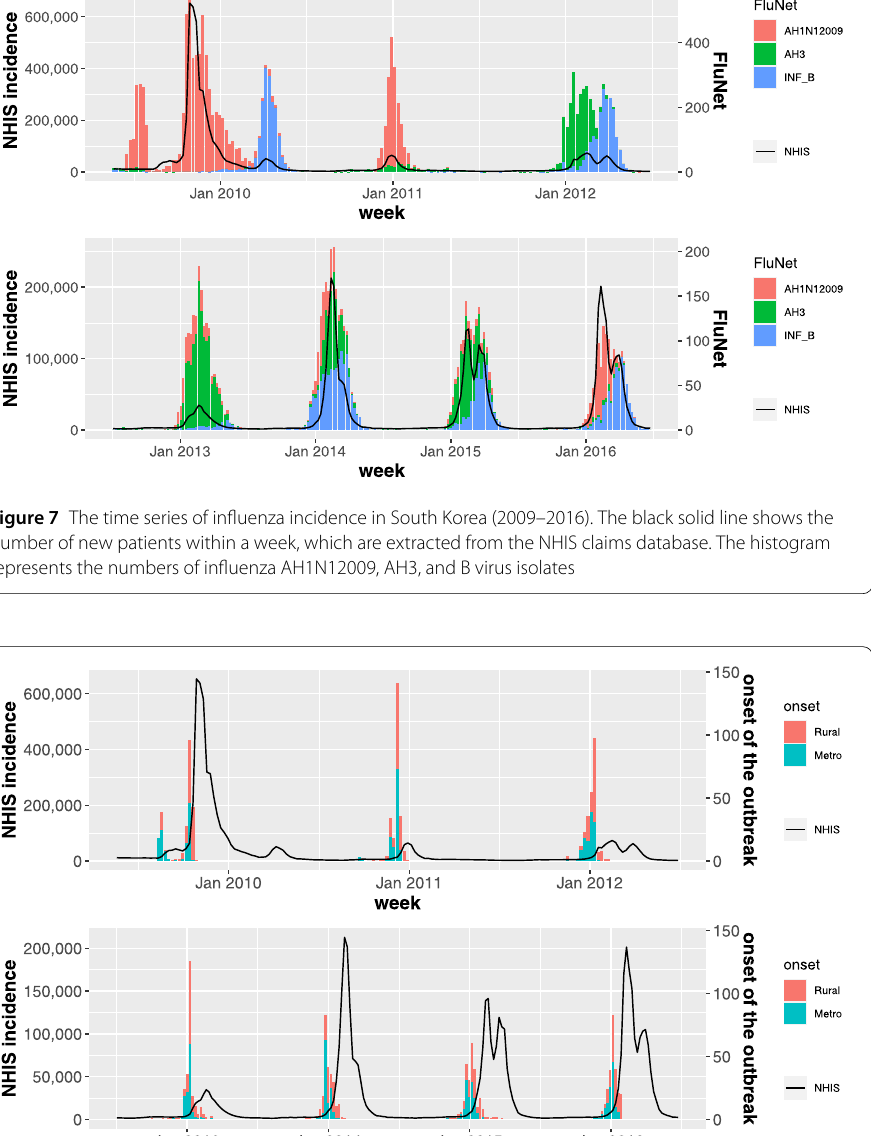
show the metro and rural areas depicted in gray and white, respectively. Although there are some rural regions among those marked in red, the results of Fig. 9 show that the metro area is earlier than the rural area for the start of the influenza